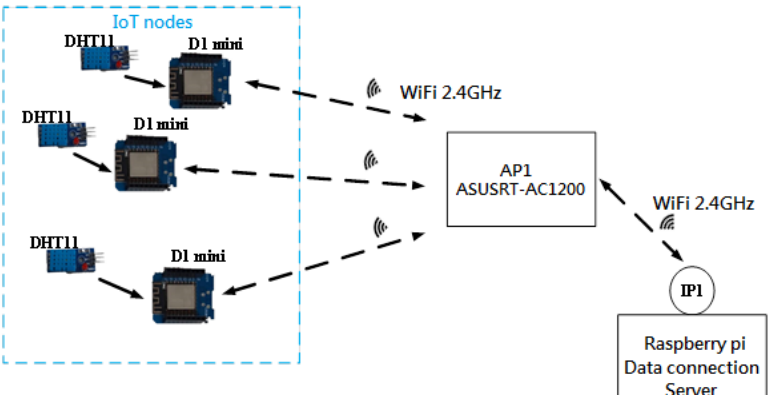
Figure 11. The architecture of IoT in the real experiment system.